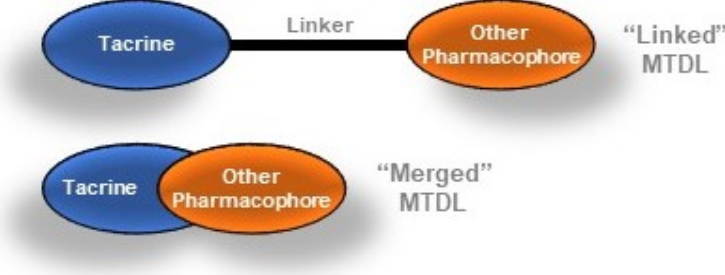
Figure 3. Tacrine-based multitarget-directed ligand (MTDLs) can be classified as “linked” or “merged” based on the degree of overlap of the pharmacophores (adapted with permission from [57], copyright (2005) American Chemical Society).